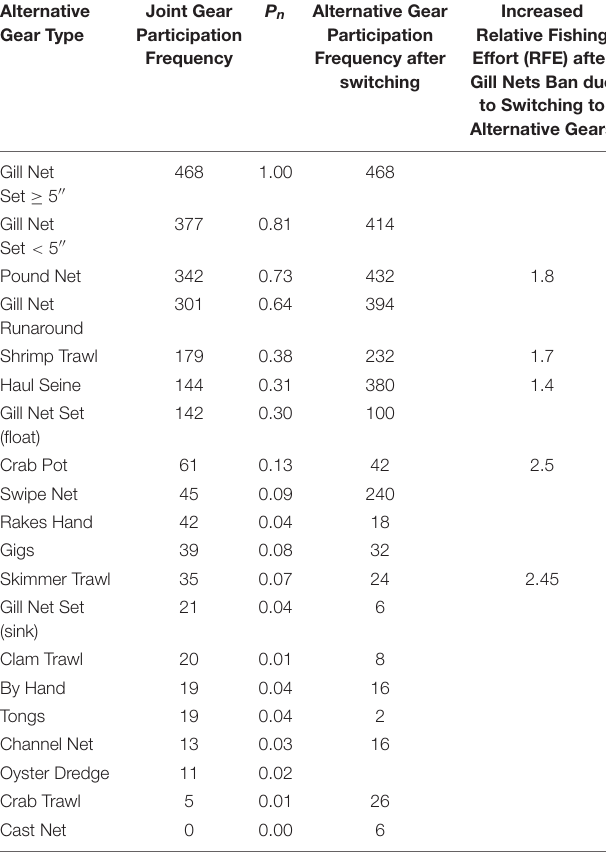
TABLE 5 | The relative frequency and proportion of shared gear use (Pn) in the affiliation network of participants involved using gill nets ≥ 5-inch mesh that also participate in other fisheries in the Core Sound commercial